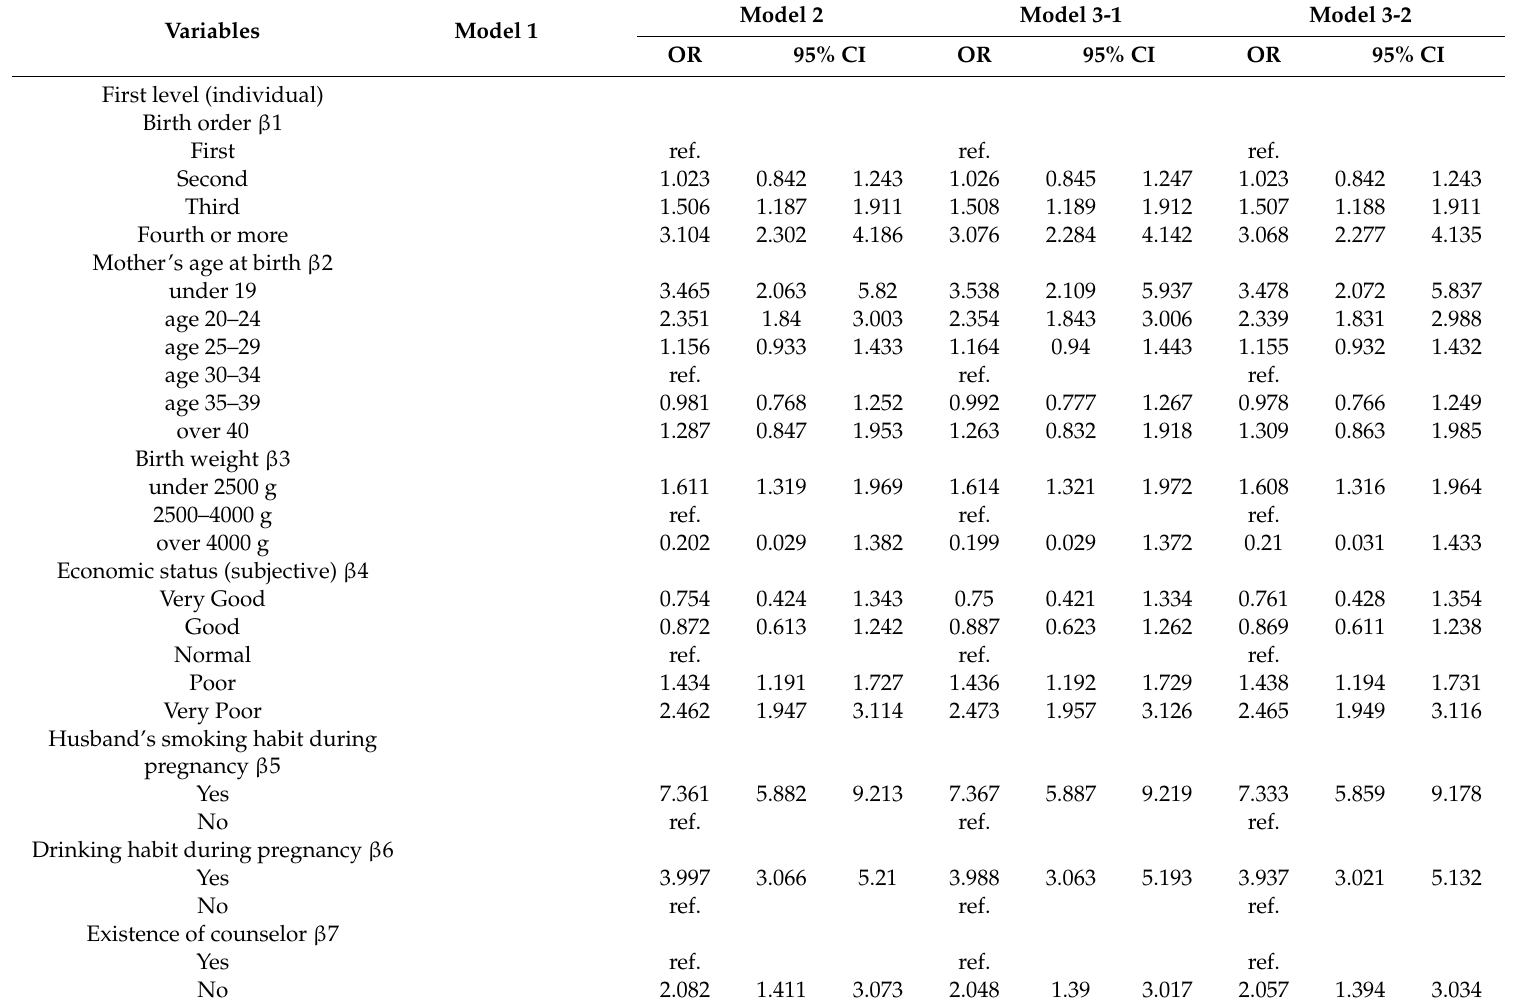
Table 4. Multilevel logistic regression analyses (Model 1–Model